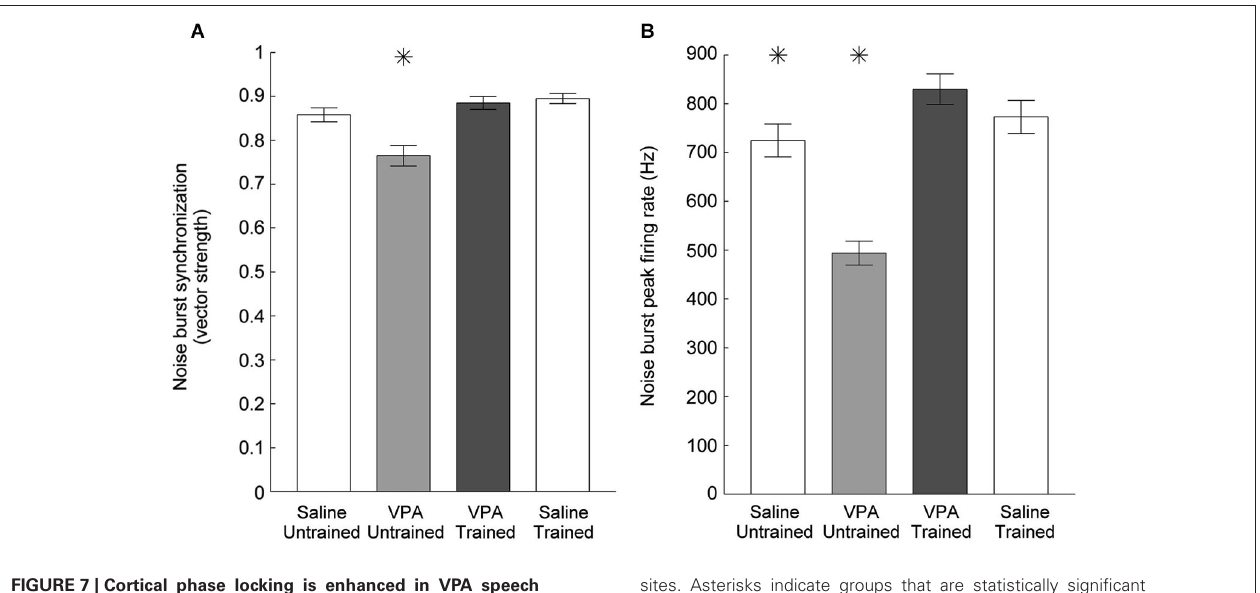
FIGURE 7 | Cortical phase locking is enhanced in VPA speech trained rats. (A) The decreased degree of synchronization in VPA untrained rats compared to saline untrained rats is restored following speech training. Error bars indicate s.e.m. across recording